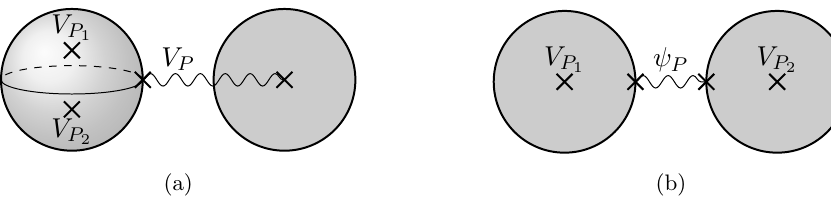
Figure 16 . (a) The OPE channel of disc bulk two-point function. (b) The boundary channel of disc bulk two-point